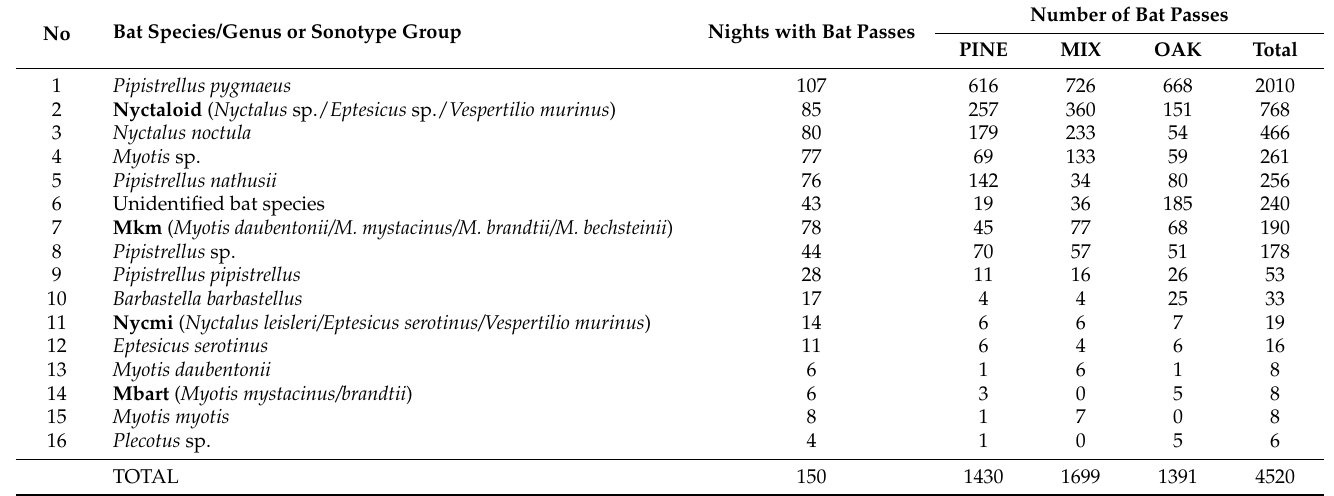
Table 2. Species of bats recorded and identified from coniferous (PINE), mixed (MIX), and deciduous (OAK)